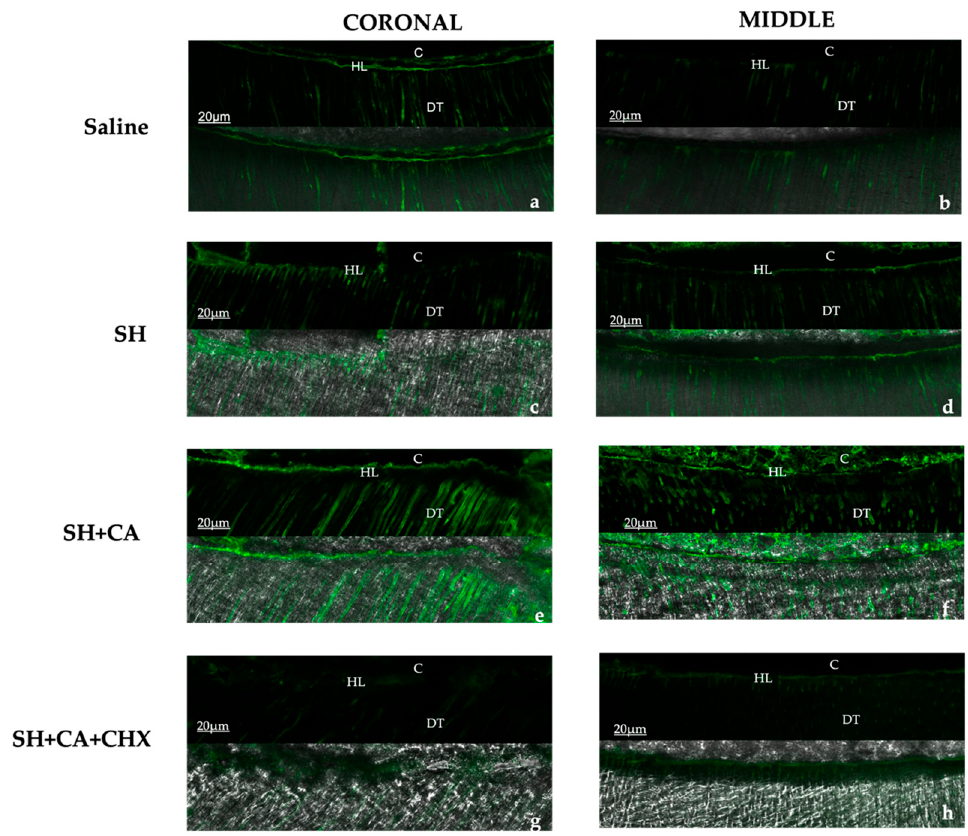
Figure 4. The sequence of representative in situ zymography images acquired with the multi-photon confocal microscope for the groups in the coronal and middle thirds, showing the green fluorescence as a result of the hydrolyzation of fluorescein-conjugated gelatin by the enzymes: saline ( a , b ); SH: sodium hypochlorite ( c , d ); SH + CA: citric acid ( e , f ); SH + CA + CHX: chlorhexidine ( g , h ). [HL: hybrid layer; DT: dentinal tubules; C: resin cement].